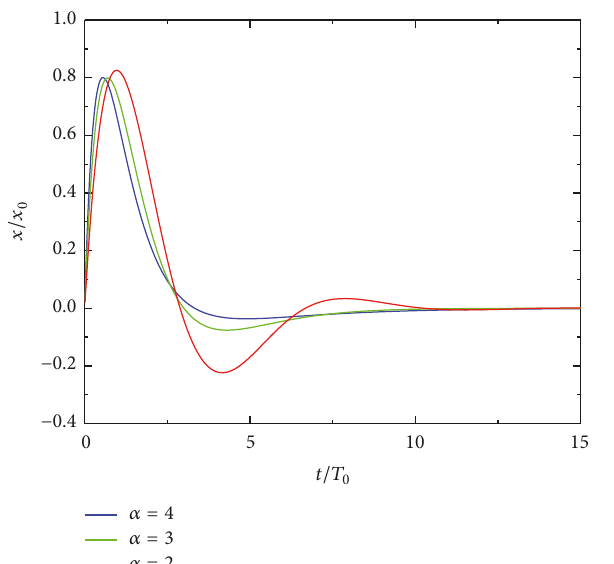
Figure 8: Free motion modes for different values of 𝛼